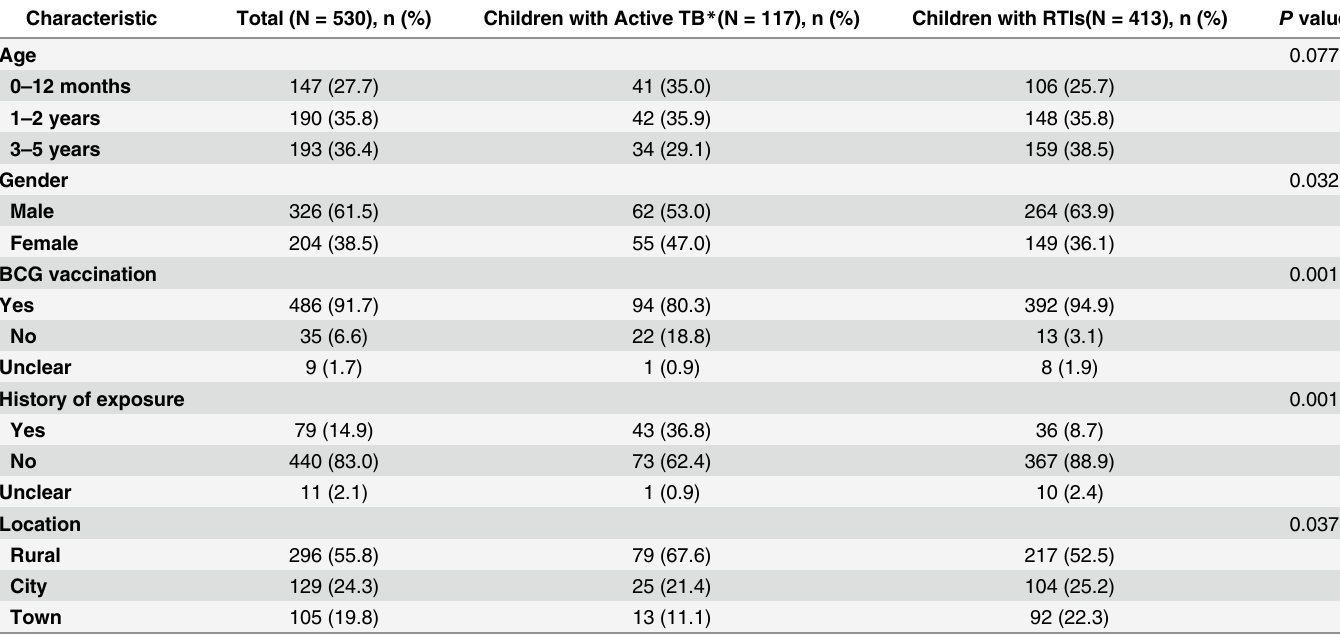
Table 1. Main clinical characteristics of the study